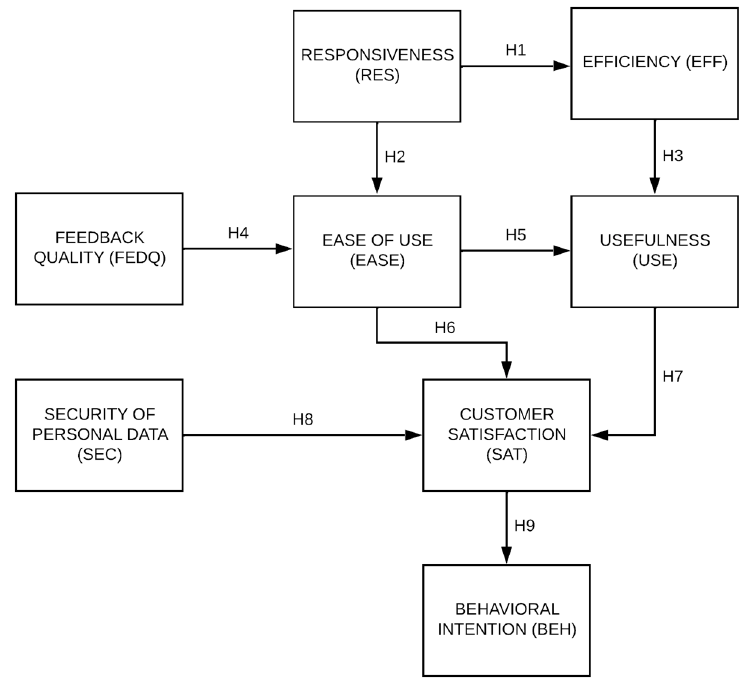
Figure 1. Research model with corresponding hypotheses.